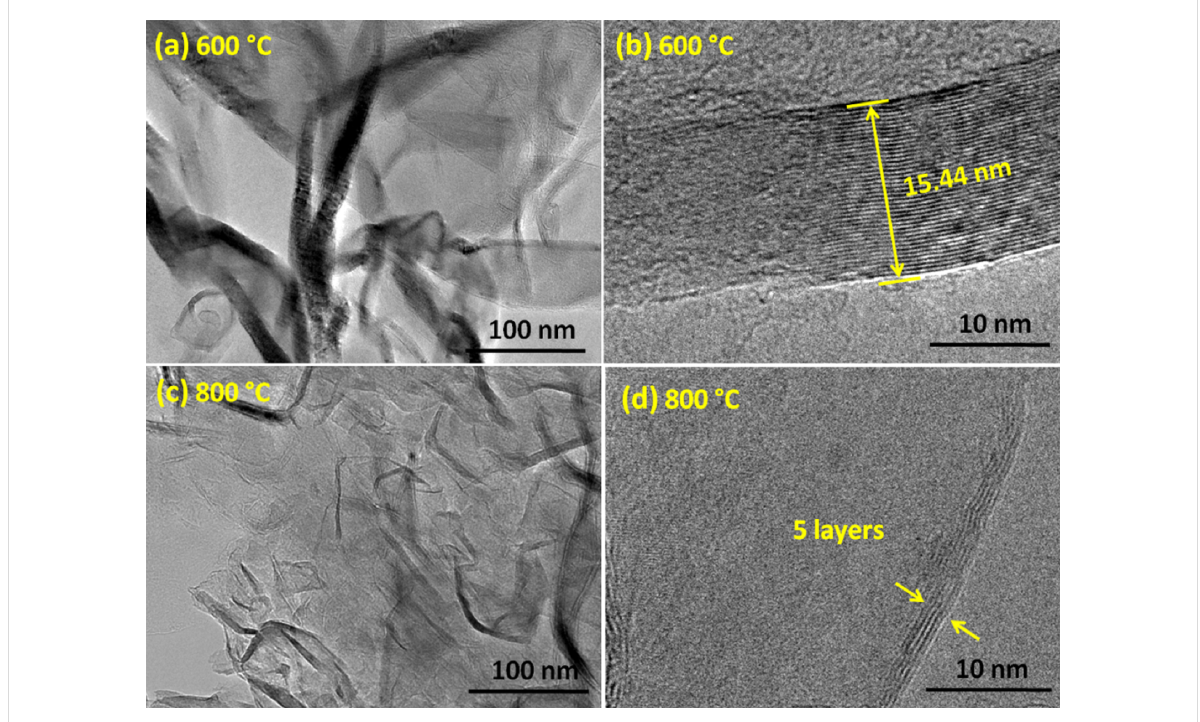
Figure 2: Transmission electron micrograph of (a,b) the nanographitic layer and (c,d) vertical graphene nanosheets (VGNs). Panel (b) shows the thickness of the nanographitic layer and panel (d) shows that the top edges of VGNs consist of only five graphene layers.